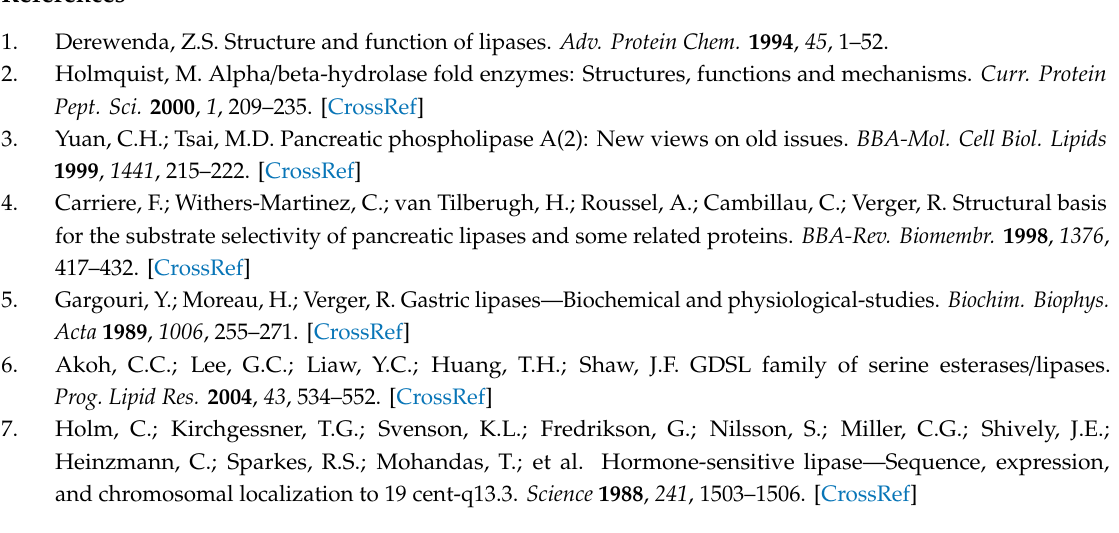
Table S1: The lipases identified in the venom of various parasitoid wasp species. Table S2: Primers of the selected lipase sequences for qPCR. Table S3: The information of all identified lipases of P. puparum . Table S4: FPKM values of lipases from di ff erent libraries of P. puparum